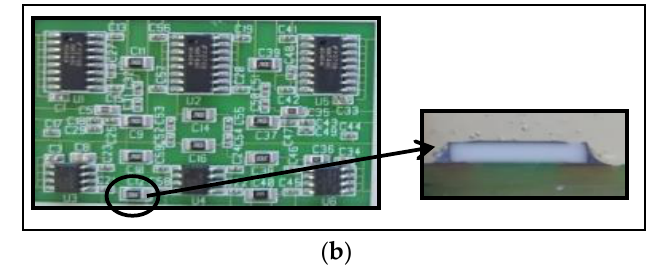
Figure 14. ( a ) Optical micrograph of the prepared microsection for the measurement of the wetting angle formed between the SAC 305 alloy and Sn-rGO composite coating after reflow at 245 °C; ( b ) images of the sample surface mounted PCBs and microsection through the solder joint on the PCB pre-coated with Sn-rGO composite.